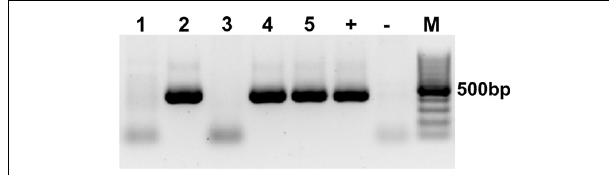
FIGURE 2 | Genotyping of the DN-CBRb mouse model. PCR with primers specific for the CB-Rb1 fusion transgene resulted in a 401 bp band in the DN-CBRb-positive animals (lanes 2, 4, and 5), but not in those lacking the transgene (lanes 1 and 3). rtTA genotype was carried following the protocol available at the Jackson Laboratories website (http://jaxmice.jax. org/strain/006965.html). ( + ) = Control DNA showing the transgene. ( − ) = Control PCR not containing DNA. M = 100 bp DNA